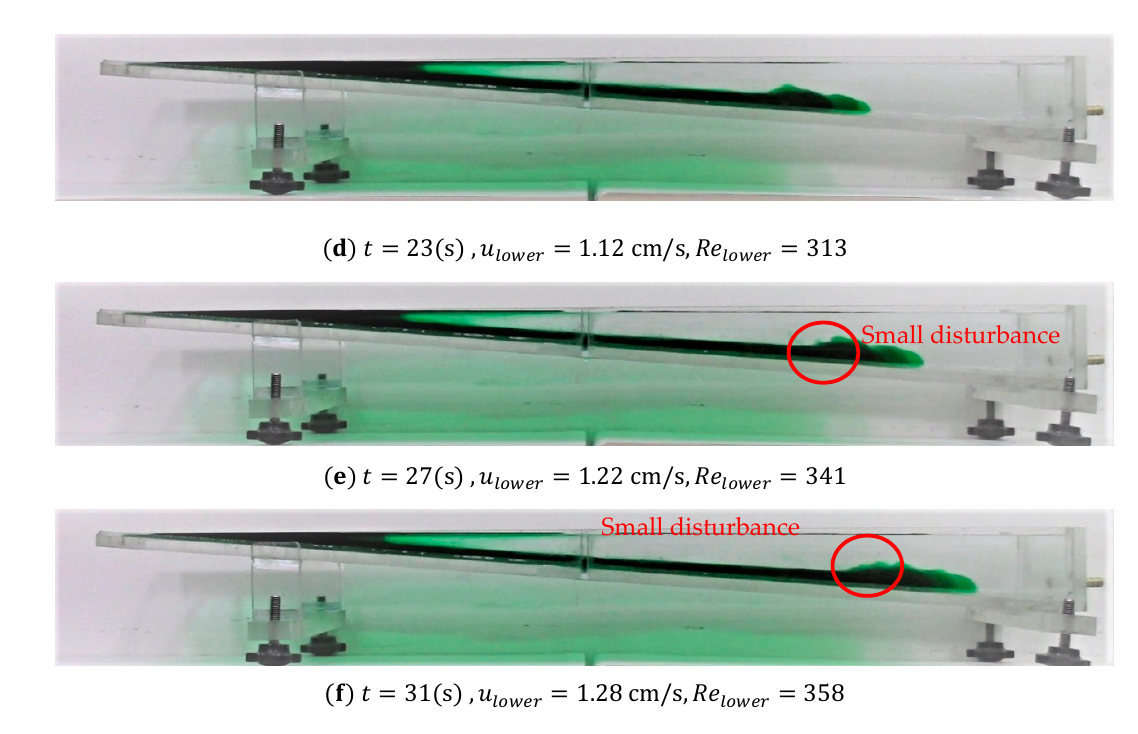
Figure 3. The time-series experimental images in Run 1 with the lower toe current speed u lower and its corresponding Reynolds number, Re lower .